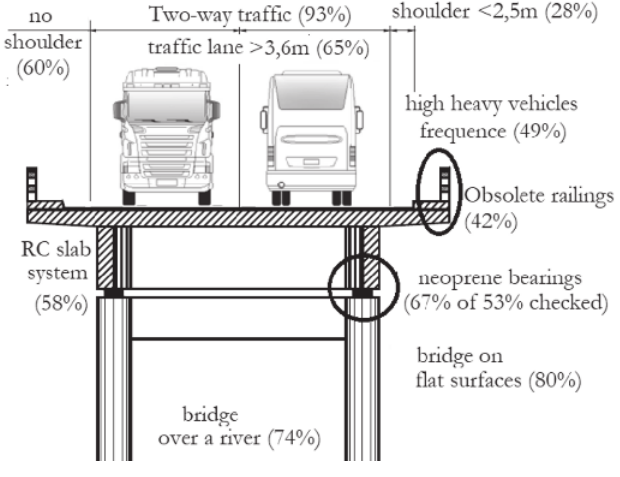
Typical cross-section of Brazilian